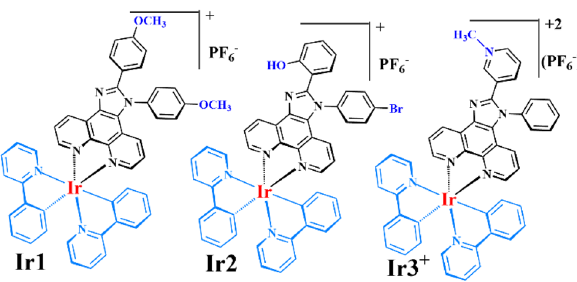
Figure 1. Molecular structures for emitter Ir1, Ir2, Ir3 +